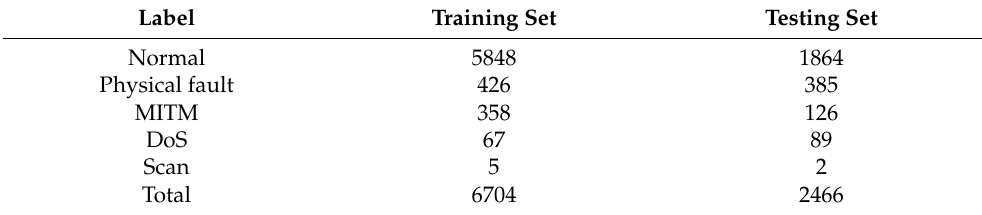
Table 5. Dataset information for supervised algorithms.